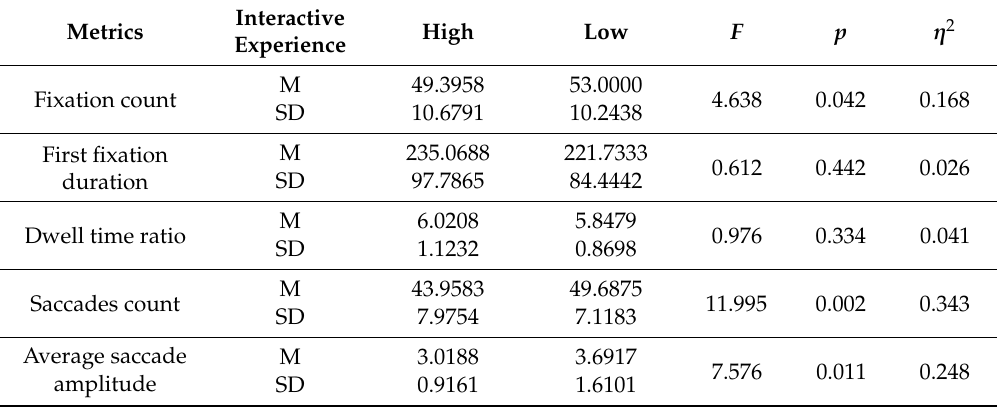
Table 2. Repeated measurement ANOVA of eye-movement metrics in free browsing mode.